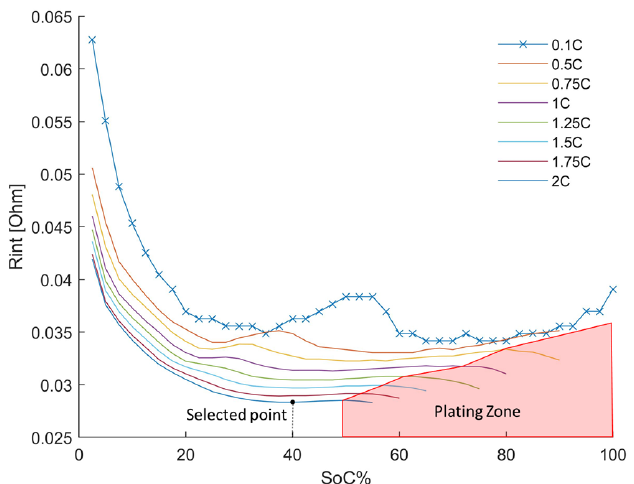
Figure 10. Internal resistance as a function of SoC during charging at several C-Rates. Crosses in 0.1 C line represents the frequency of data points for all measurements. 0.1 C line represents the frequency of data points for all